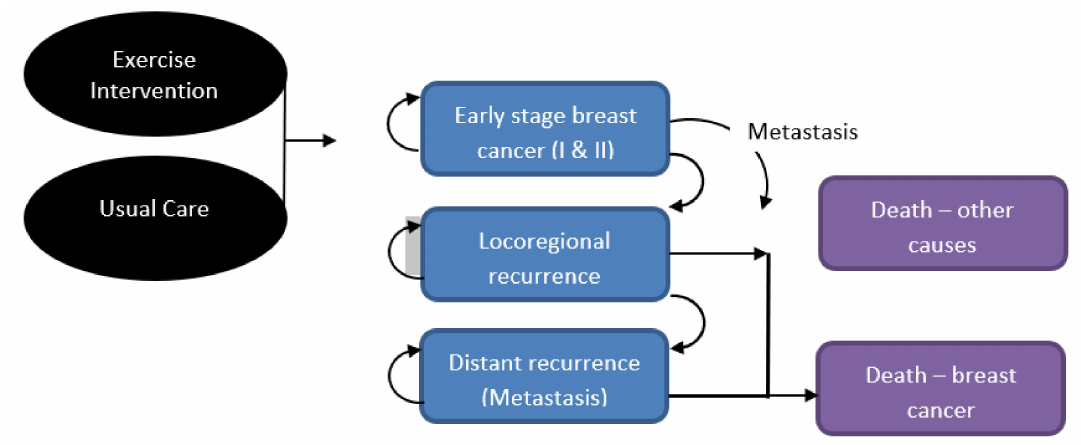
Figure 1. Illustration of Markov model health